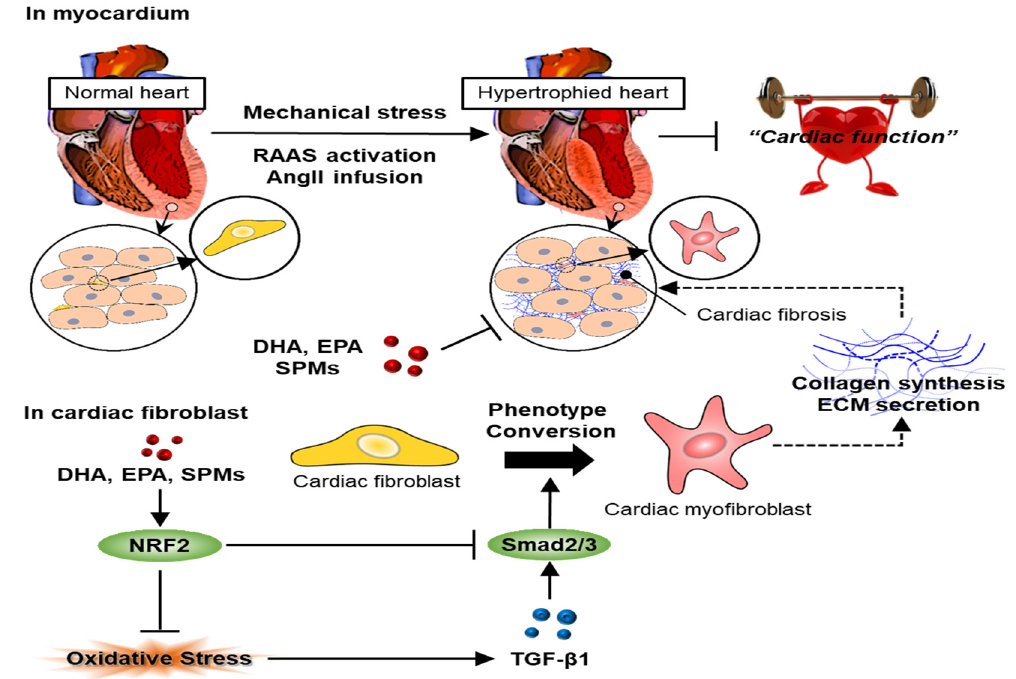
Figure 1. Schematic diagrams depicting the mechanisms of SPMs in alleviating cardiac fibrosis in Ang-II-infused mice. Irisin activated and accelerated the translocation of Nrf2 to the nucleus, thereby reducing oxidative stress and countering the ROS / TGF- β 1 / Smad2 / 3 pro-fibrotic pathway (modified from Chen et al. [6]).